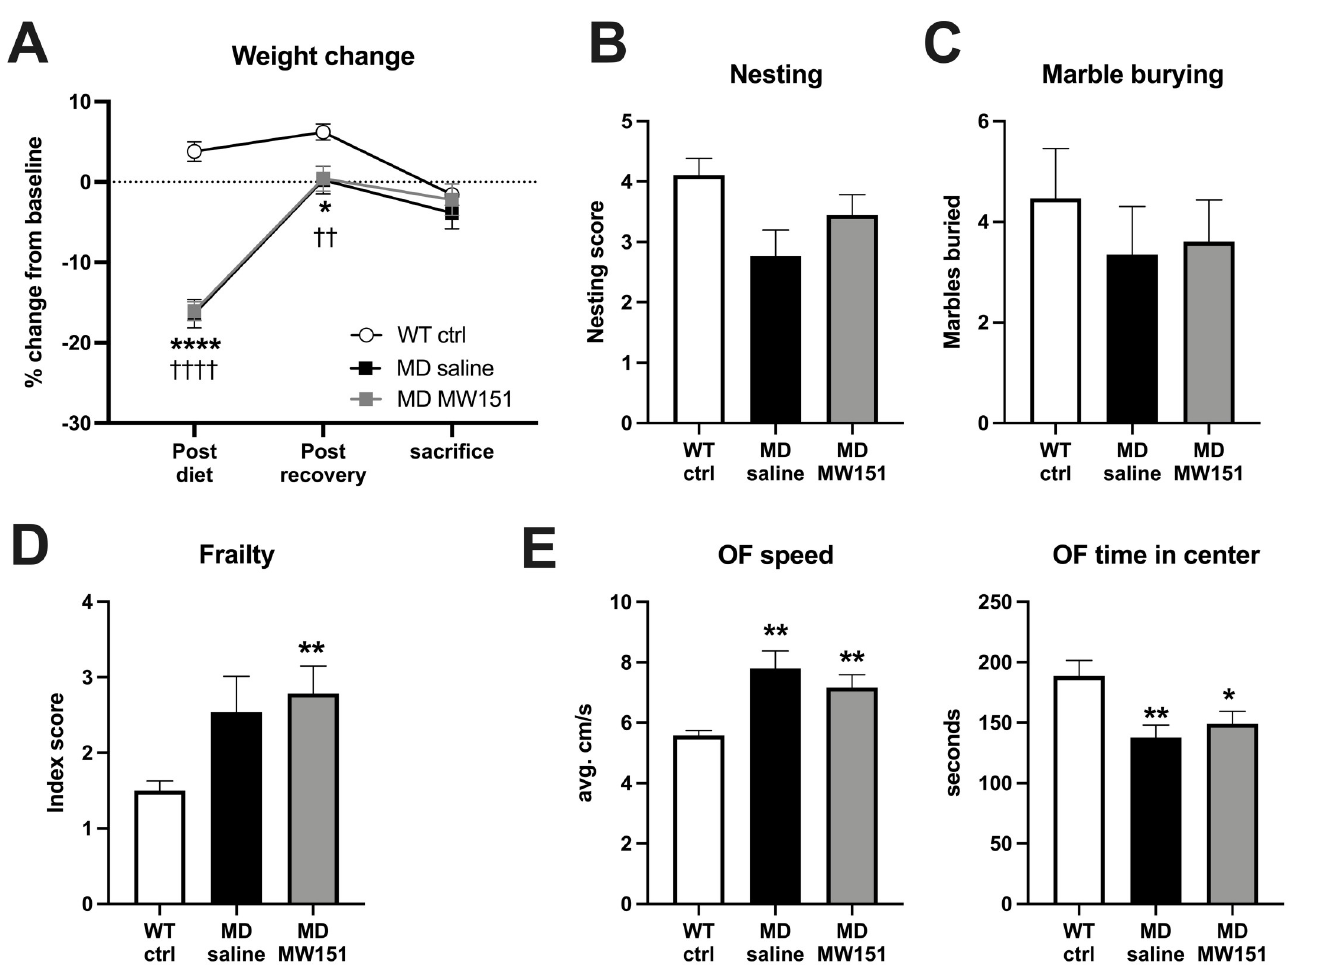
Fig 1. MD mice show altered non-cognitive behaviors versus WT control, unaffected by treatment with MW151. ( A ) MD mice in both treatment groups lost significant weight on HHcy diet, which was recovered by time of sacrifice and unaffected by MW151 treatment. Results of two-way mixed measures ANOVA revealed a significant effect of time ( F (1.693, 86.34) = 178.0, p < .0001), group ( F (3, 51) = 13.02, p < .0001), and a time by group interaction ( F (6, 102) = 24.02, p < .0001). ���� p < .001, � p < .05 for the MD saline mice versus WT ctrl comparisons and ††††p < .001, ††p < .01 for MD MW151 versus WT ctrl, Sidak’s posthoc tests. ( B ) No significant differences between groups are observed in the nesting assay, despite overall significance in the Kruskal-Wallis test ( H (4) = 9.833, p = 0.020). ( C ) No differences in the number of marbles buried are observed between any of the groups ( F (3, 51) = 0.3992, p = 0.75). ( D ) There was a significant effect in the Frailty index scores ( H (4) = 10.78, p = 0.0129), with the MD MW151 mice found to have a significantly higher score than WT ctrl, �� p < .01, Dunn’s post hoc test. ( E ) Open field speed and time in center are shown, where the MD saline mice have a higher average speed than WT ctrl, and also spend less time in the center of the arena. MW151 does not alter either of these parameters. Results of one-way ANOVAs showed significant overall differences in average OF speed ( F (3, 51) = 10.89, p < .0001) and OF time in center ( F (3, 51) = 4.038, p = 0.0119), �� p < .01, � p < .05 versus WT ctrl group, Holm-Sidak post-hoc comparisons. objects were replaced with identical but clean objects, but the upper right corner object moved instead to the lower right corner. Mice were then returned to their assigned arena for the test- ing phase, wherein they were given 5 minutes to freely explore both objects. Detection of nose- point within 1 cm of the object counted as exploration of that object. Six-arm radial arm water maze (RAWM). RAWM was run according to the protocol previously described [19]. Briefly, the maze consisted of six arms in a circular tank filled with water containing non-toxic white tempera paint. The tank was enclosed by black curtains arranged in a square, with geometric extra-maze visual cues affixed to three of four curtain